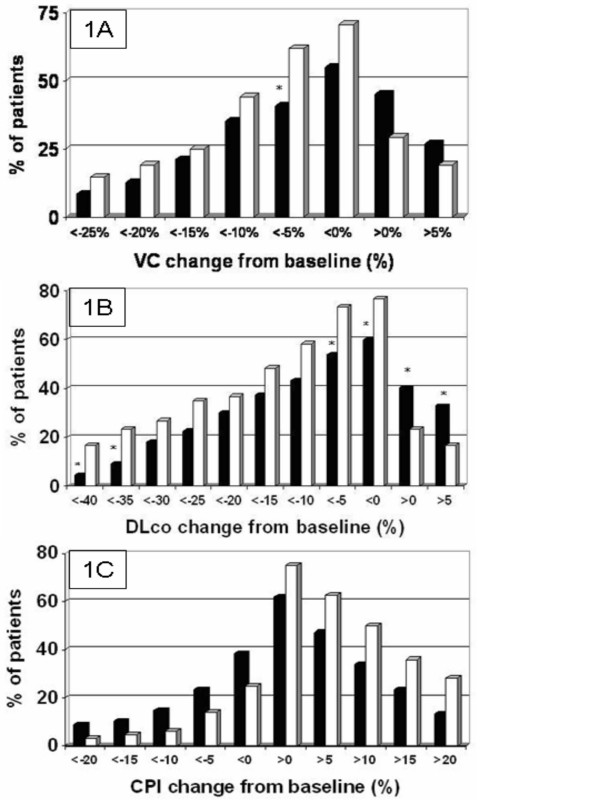
Categorical analyses in steps of 5% change from baseline during the one year study period. a: VC: Higher percentages of patients receiving NAC (black columns) showed any improvement and improvement of 5% or more as compared to baseline, whereas higher percentages of patients receiving placebo (white columns) showed any deterioration or decreases of VC of more than 5, 10, 15, 20, and 25% from baseline; this difference was significant at the 5% level (* p < 0.05 NAC vs plac). b: DLco#: A higher percentage of patients receiving NAC (black columns) showed improvement and a lower percentage of patients receiving NAC (black columns) showed deterioration of DLco as compared to placebo (white columns). The differences were statistically significant at the levels <-40%, <-35%, <-5%, >5%, any deterioration, and any improvement (* p < 0.05 NAC vs plac for each of these comparisons). # numbers refer to DLco Hb corrected. c: CPI: A higher percentage of patients receiving NAC (black columns) showed improvement (i.e. decrease) and a lower percentage of patients receiving NAC (black columns) showed deterioration (i.e. increase) of the CPI as compared to placebo (white columns). The differences were statistically not significant.